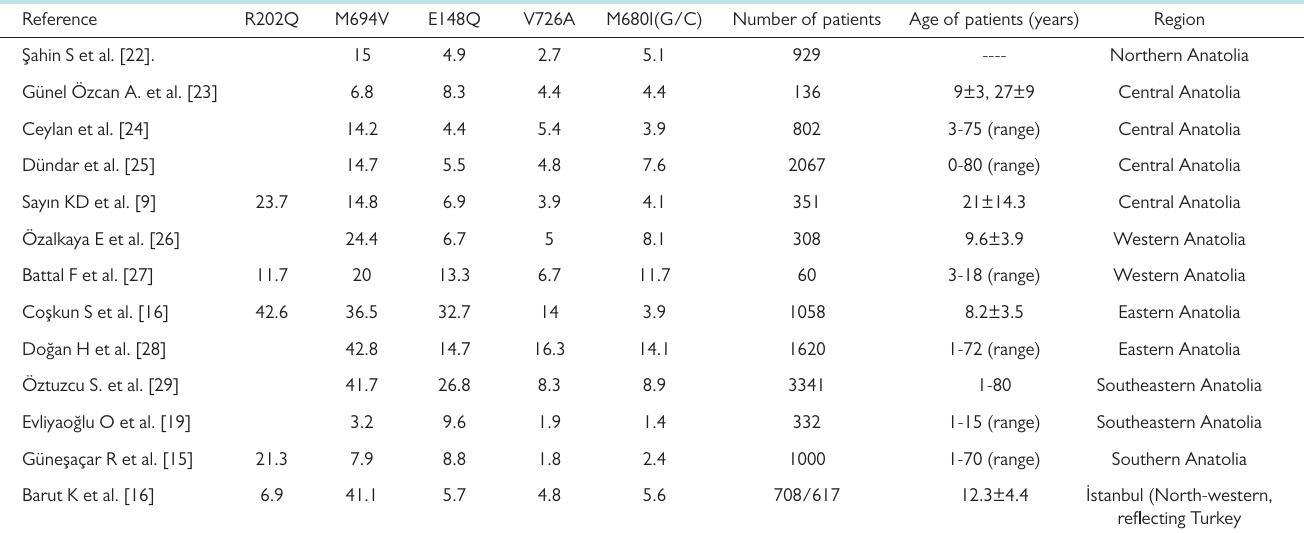
Table 3. Common MEFV alteration frequencies in patients suspected with FMF in pediatric population from different regions of Turkey (%) Reference R202Q Age of patients